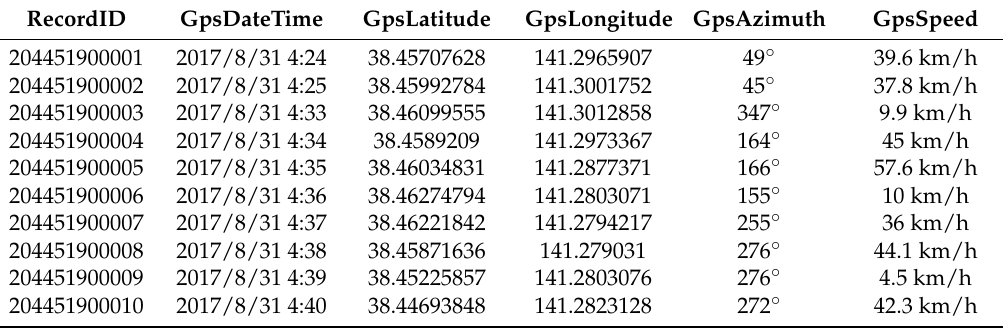
Table 3. Probe-car sample data